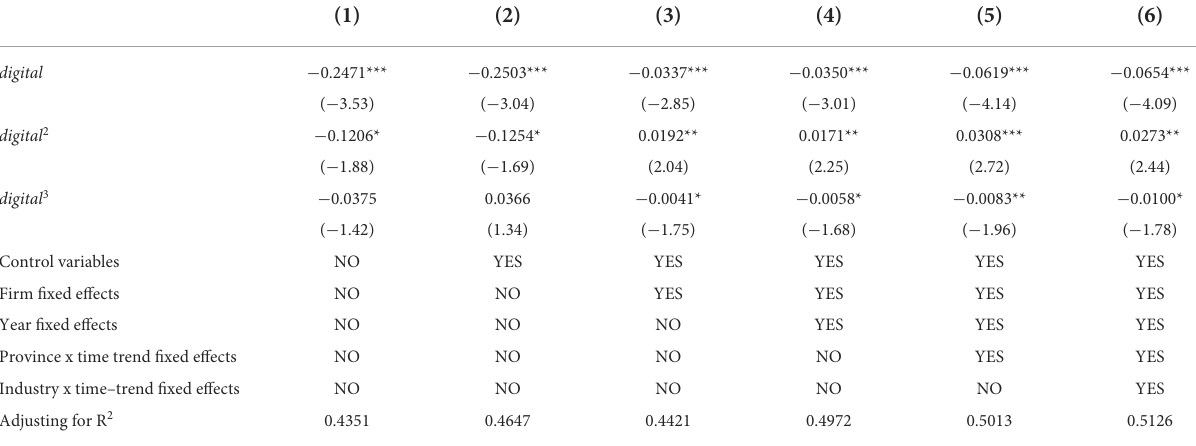
TABLE 1 Estimated results of the impact of digital finance on the carbon intensity of the manufacturing